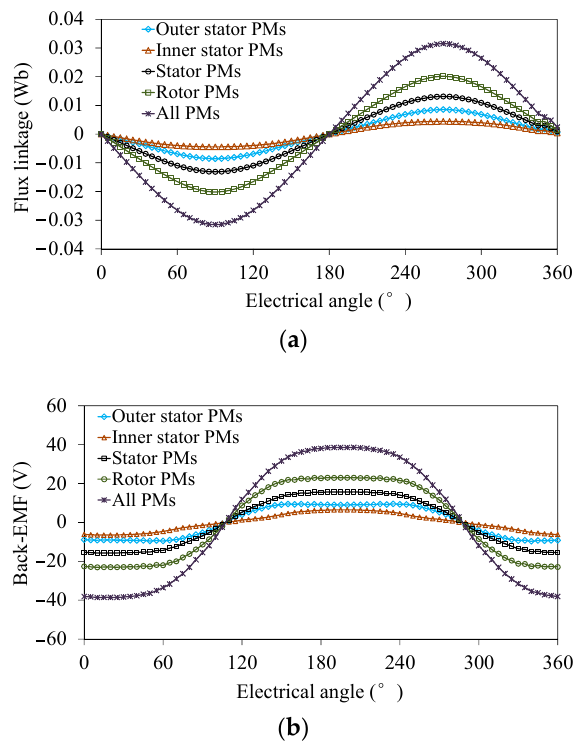
Figure 11. Flux linkage and Back-EMF in primary windings due to different excitation sources. ( a ) Flux linkage; ( b ) back-EMF.